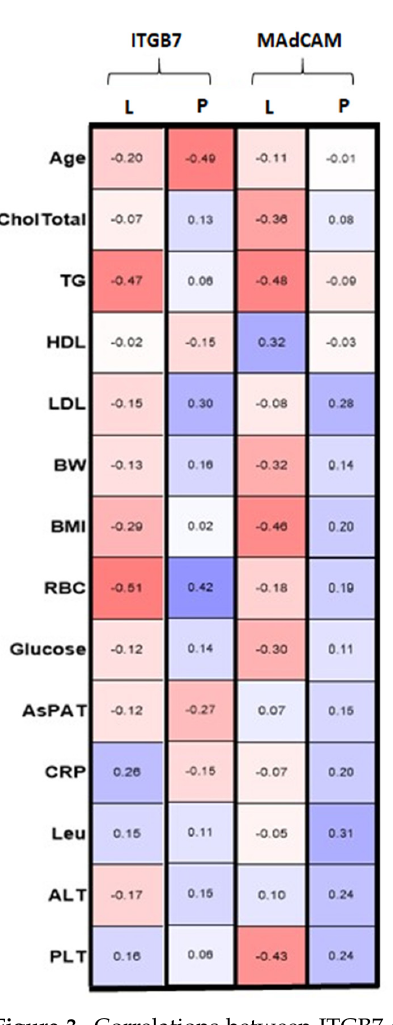
Figure 3. Correlations between ITGB7 and MAdCAM-1 concentrations and other parameters in pa- tients with PSO (P) and LP (L). RBC, red blood cells; PLT, platelets; LEU, white blood cells; TG, triglycerides; HDL, high-density lipoprotein; LDL, low-density lipoprotein; CRP, C-reactive protein; ALT, alanine transaminase; AST, asparagine transaminase.